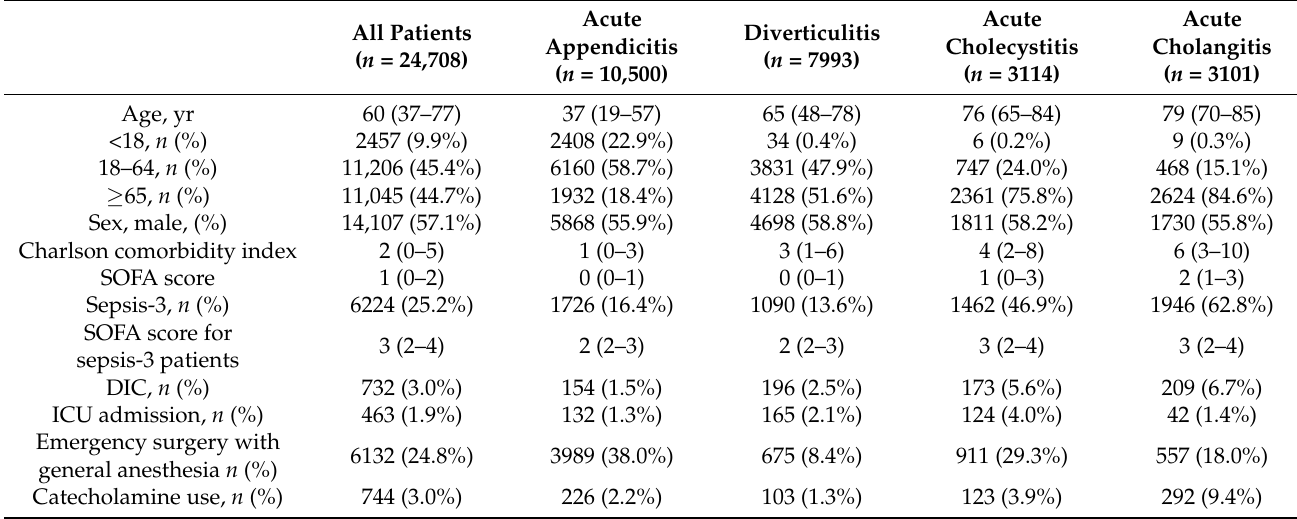
Table 1. Patient characteristics.